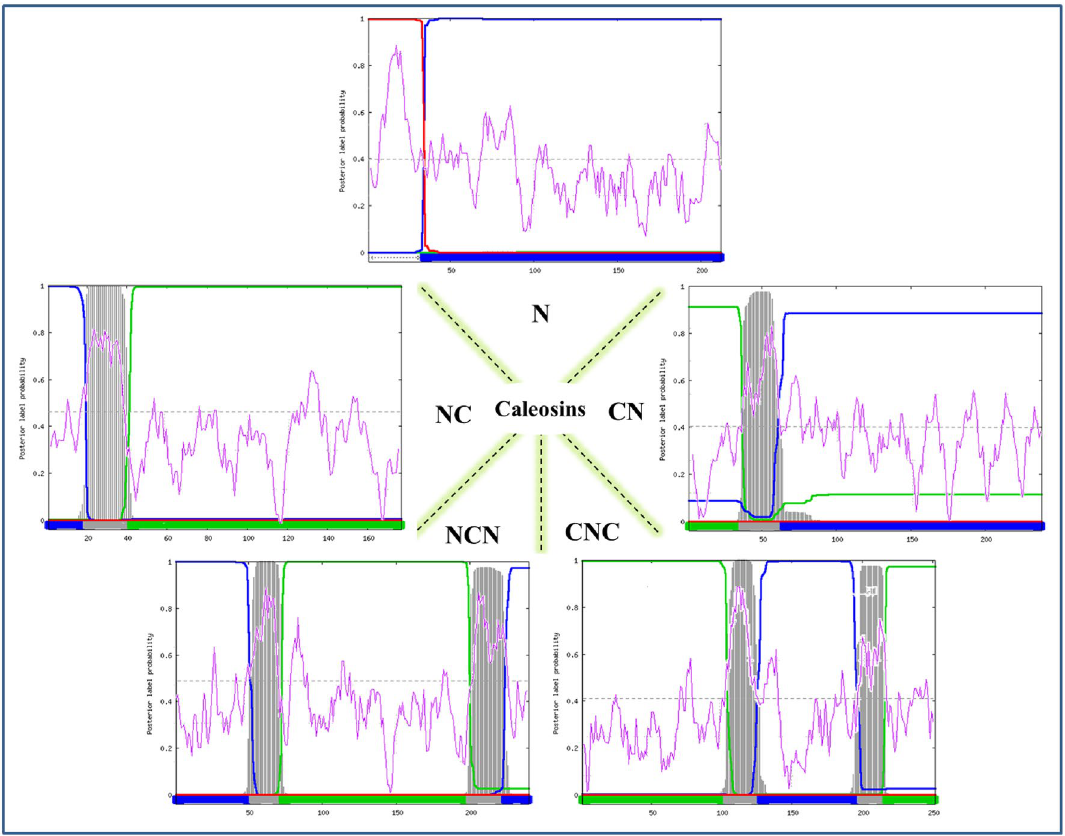
Figure 1. Caleosin classification according to the transmembrane topology by Phobius. The signal peptide, cytoplasmic and non-cytoplasmic regions are indicated with red, green and blue lines, respectively. The purple line shows the hydrophobic analysis by ProtScale. The zero score is drawn with a black dashed line.